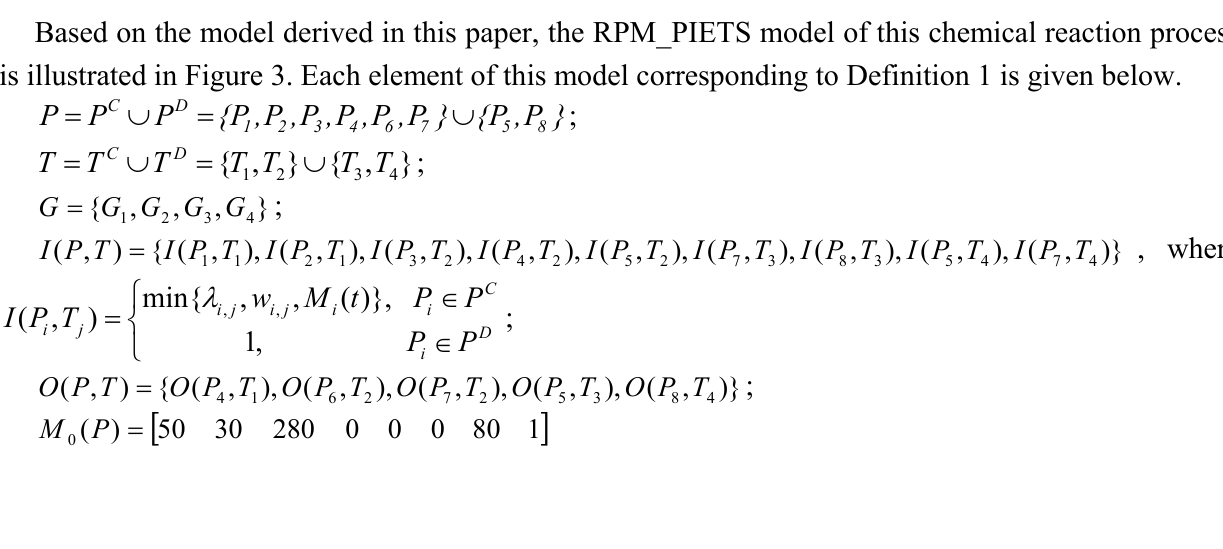
Figure 2. Simulation mechanism for RPM_PIETS